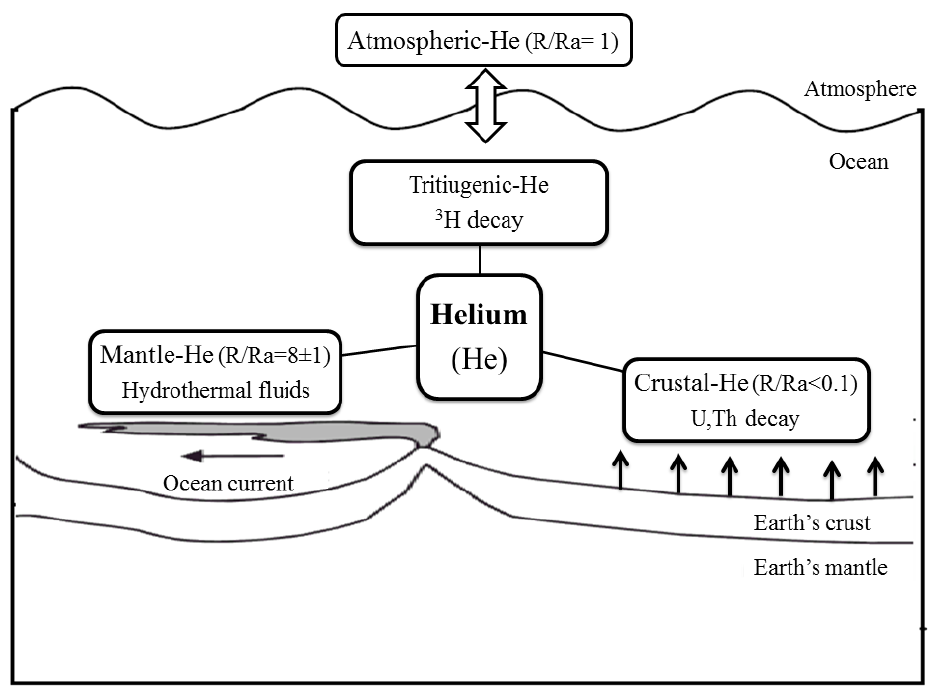
Figure 1. Schematic of helium components in the ocean. Note that the tritiugenic component consists of 3 He only. At the ocean surface, helium is essentially in solubility equilibrium with atmospheric